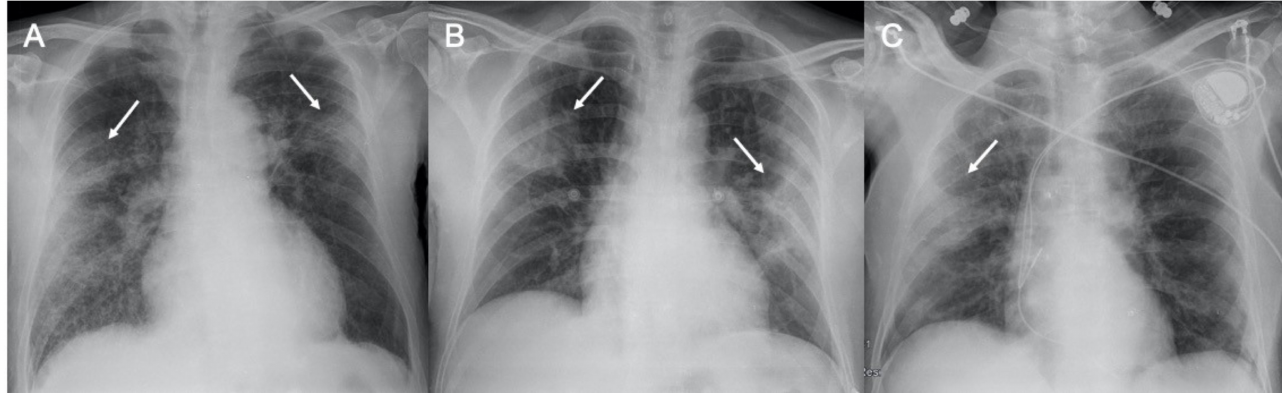
Figure 1. Chest radiograph in COVID-19 pneumonia. Three cases of supine chest X-ray with subpleural consolidations (arrows), in ( A , B ) with bilateral involvement, and in ( C ) with main involvement of the right lung.